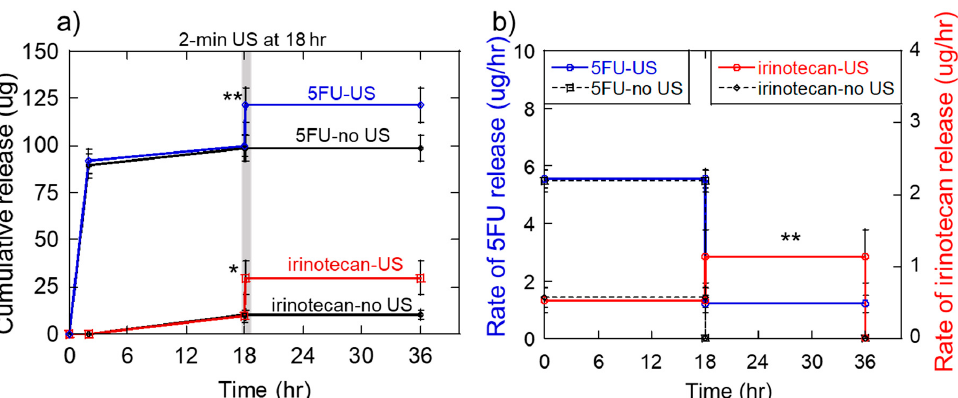
Figure 8. Ultrasonically responsive gels can be used to generate a triggered release of irinotecan after an initial burst release of 5-fluorouracil. ( a ) Cumulative release of 5-fluorouracil (blue) and irinotecan (red) vs time when ultrasonically stimulated for 2-min at 40% US amplitude at 18 h. Control gels (black) were not subjected to ultrasonic stimulation at 18 h. ( b ) The 18-h average rate of 5-fluorouracil and irinotecan release vs. time for the same conditions presented in part (a). * and ** indicate statistically significant differences with p < 0.05 and 0.01, respectively, relative to controls. N = 4.